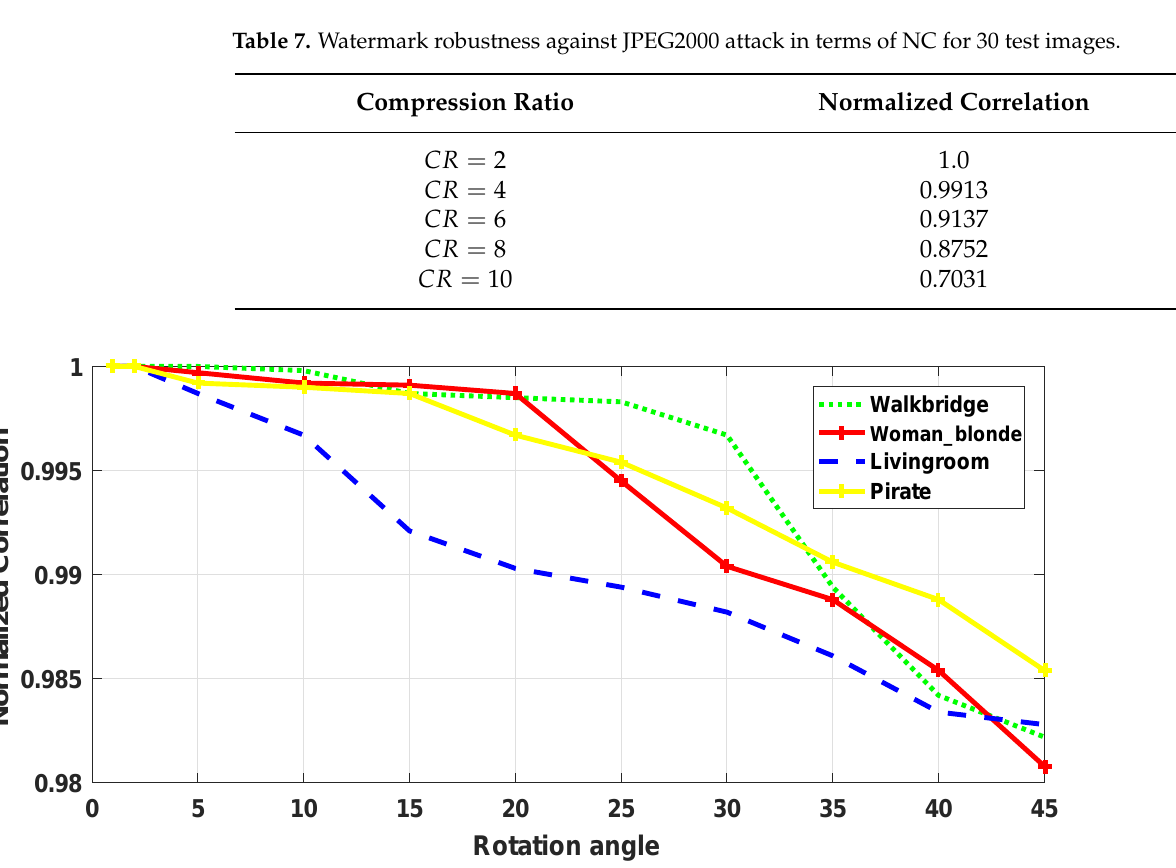
Figure 10. Robustness in terms of NC against rotation